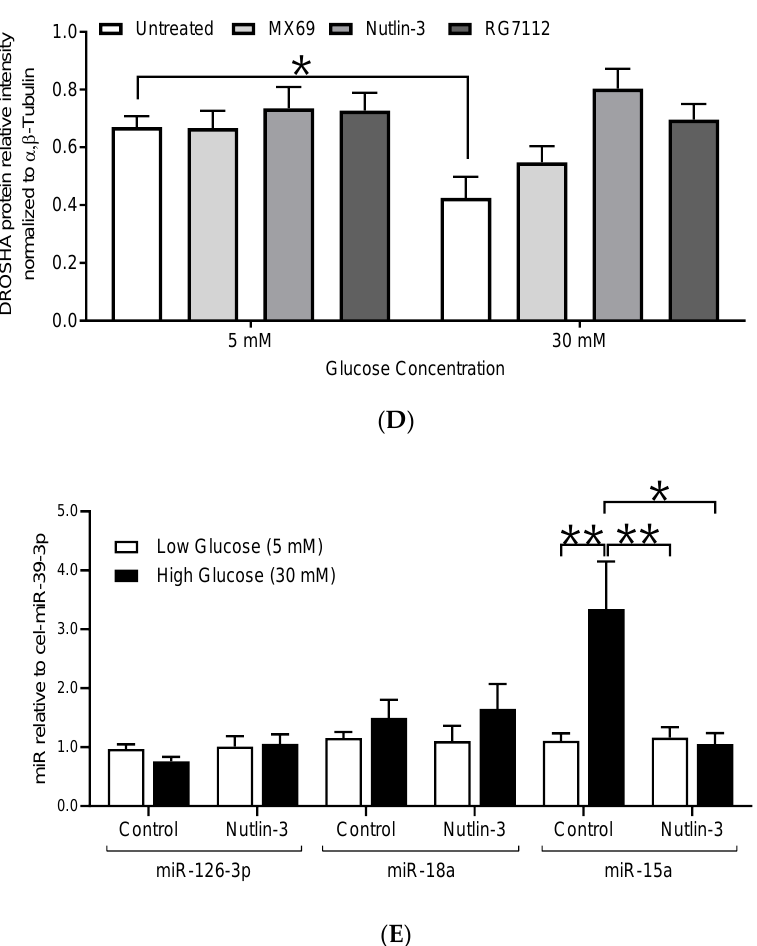
Figure 4. High glucose treatment increases MDM2 expression in human dermal microvascular endothelial cells (HDMECs) and enhances MDM2-DROSHA interaction. ( A , B ) HDMECS were treated for 24 H treatment with 30 mM or 5 mM glucose